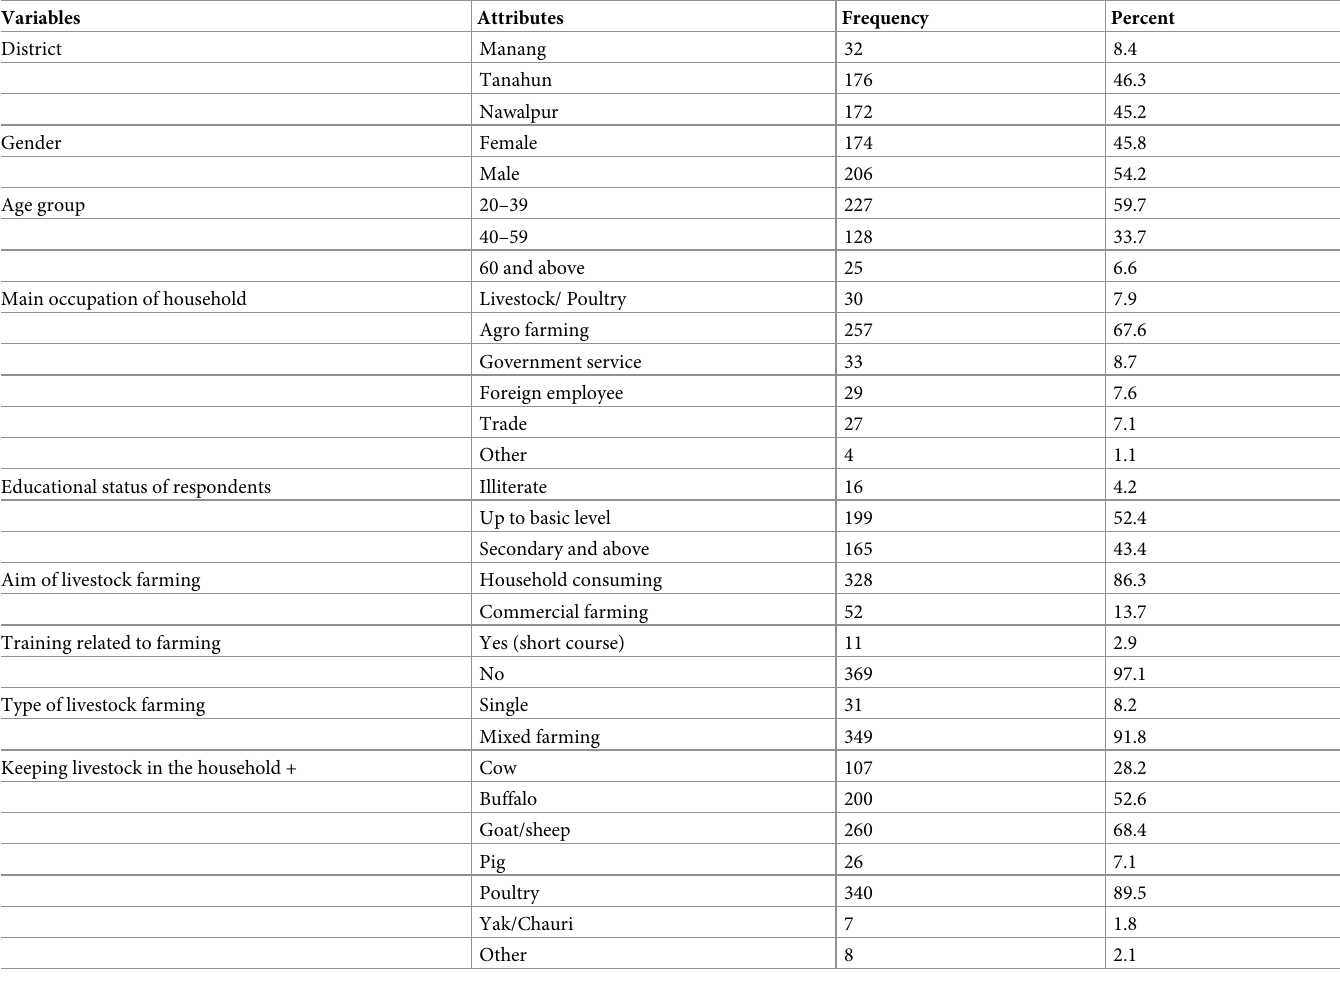
Table 1. Socio-demographic characteristics of the